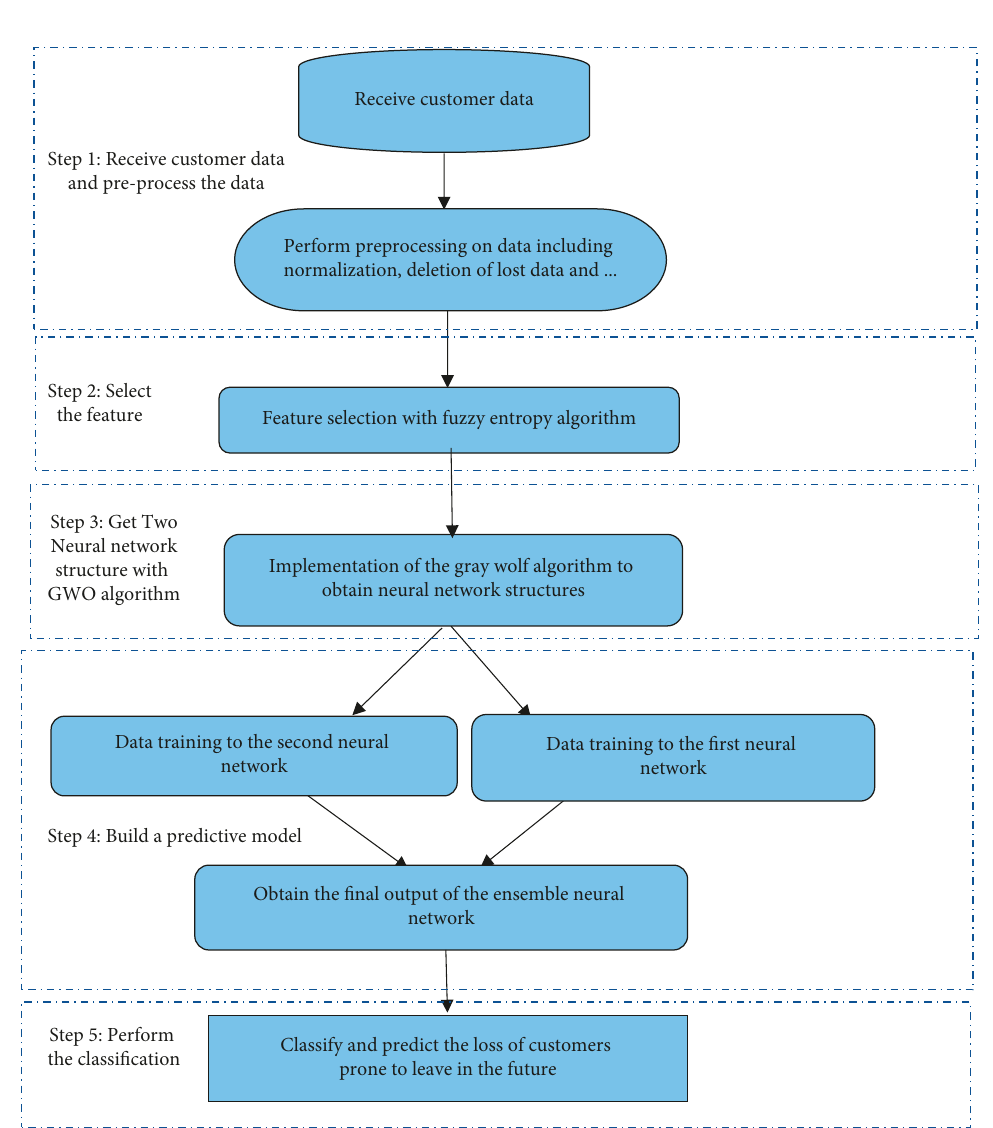
Figure 2: A hypothetical structure for the neural